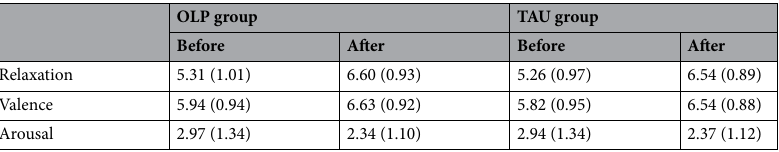
OLP group TAU group Before After Before